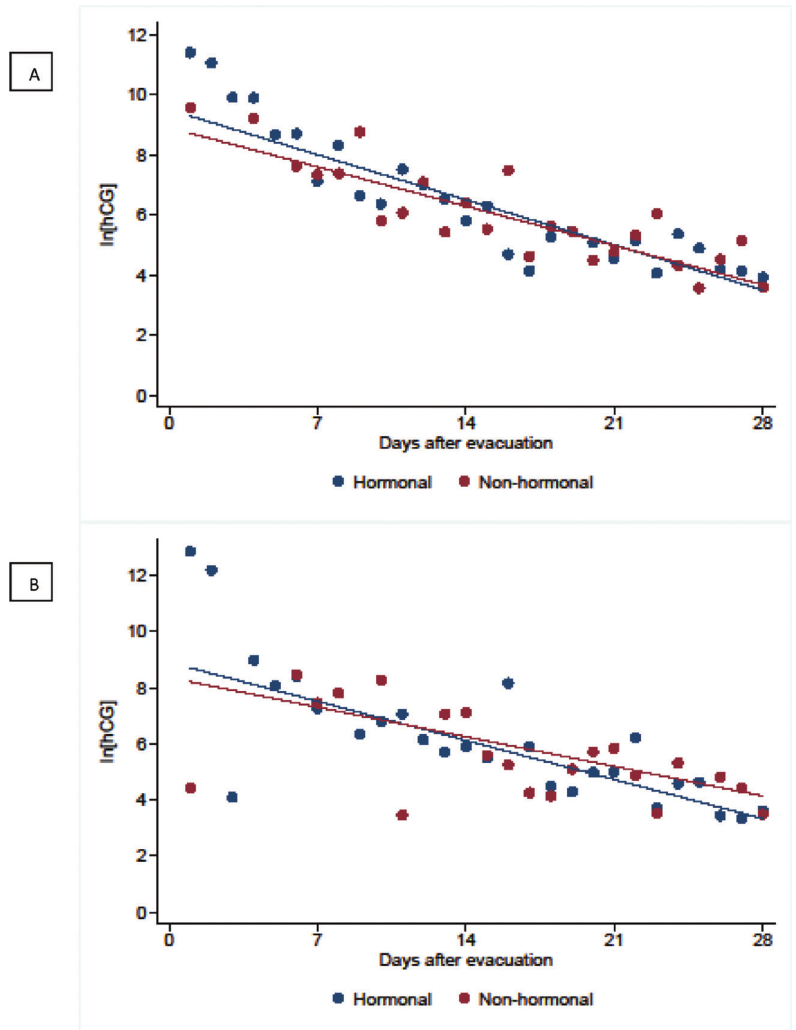
Figure S4 - Human gonadotropin (hCG) regression curves by contraception for (A) complete and (B) partial molar pregnancies. Each point represents the mean hCG level. The hCG regression rate was significantly faster in patients using combined hormonal contraception than in those using non-hormonal contraception ( p =0.002). The difference was significant among patients with partial molar pregnancies ( p o 0.001) but not in those with complete molar pregnancies ( p =0.32).